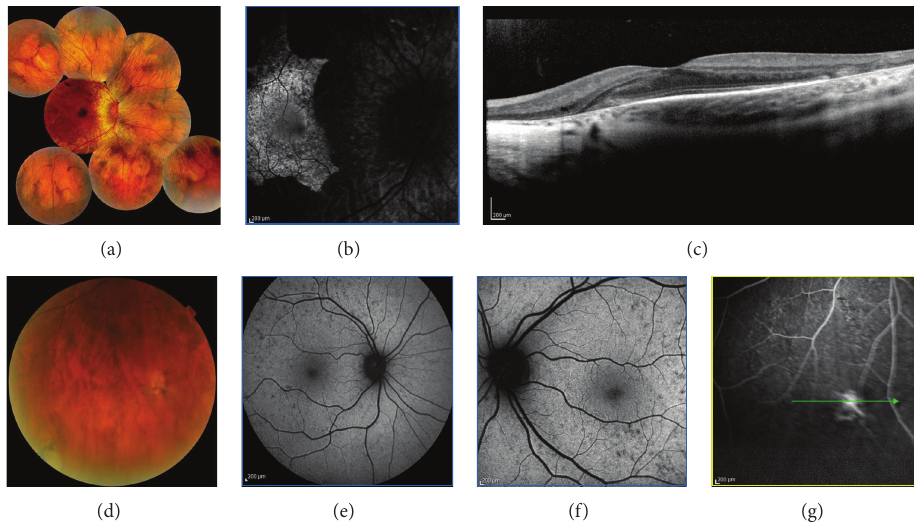
Figure 3: Fundus photograph of a male patient affected by choroideremia shows midperipheral RPE atrophy spreading peripherally with visualization of coursing large choroidal vessels and sparing of the fovea. Fundus autofluorescence demonstrates an hyperautofluorescent stellate preservation of the posterior pole. Spectral-domain OCT scans show diffuse choroidal atrophy and loss of the IS/OS junction, which is intact and preserved at the level of the fovea. The boy’s mother was a genetically confirmed female carrier: her fundus shows mild, patchy peripheral RPE mottling with a striking speckled pattern in FAF.